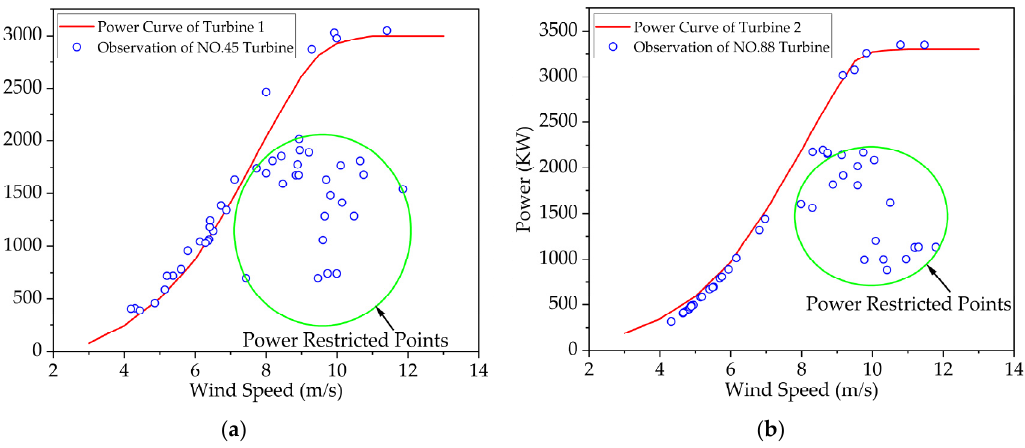
Figure 9. The power curve and power observation values for the chosen wind turbines: ( a ) power curve for Turbine 1 and power observation values for NO.45 turbine; ( b ) power curve for Turbine 2 and power observation values for NO.88 turbine. Table 3. The RMSE of power productions for selected